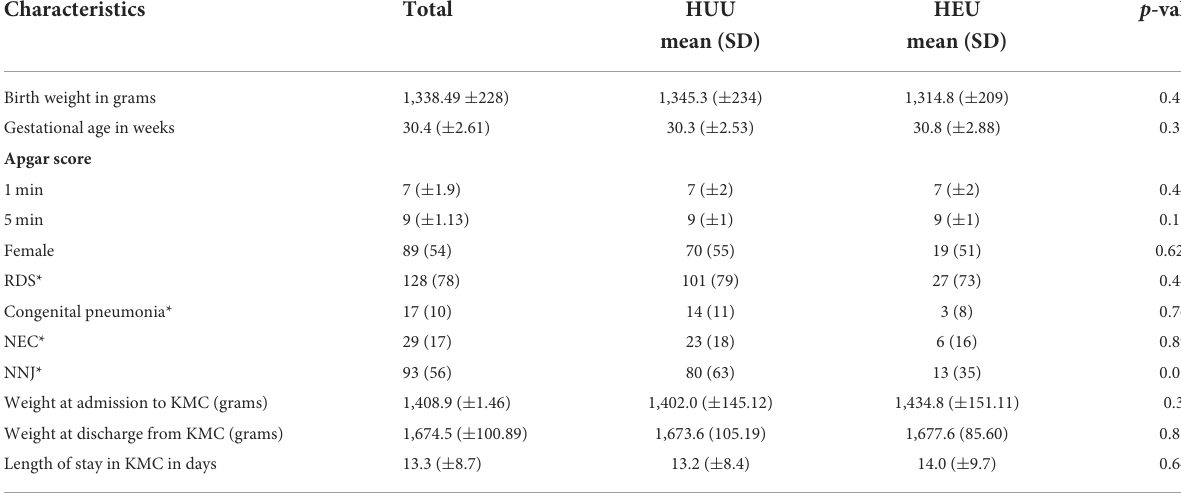
TABLE 2 Characteristics of neonates admitted to the KMC.